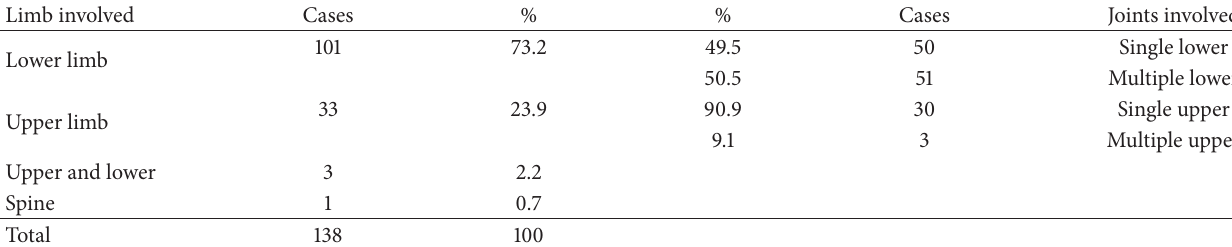
Table 1: Percentage and number of joints affected by DEH in the cases reported in the literature.